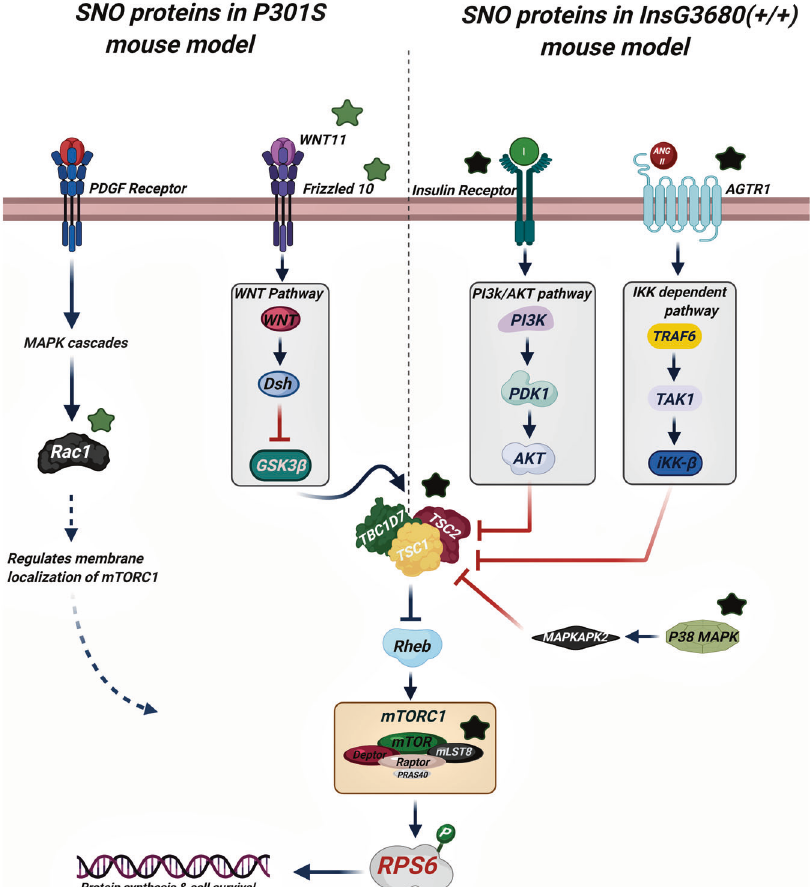
Fig. 5 The suggested scheme of the SNO-dependent mTOR activation in the ASD and AD mouse models. Green stars are SNO proteins in AD . Black stars are SNO proteins in